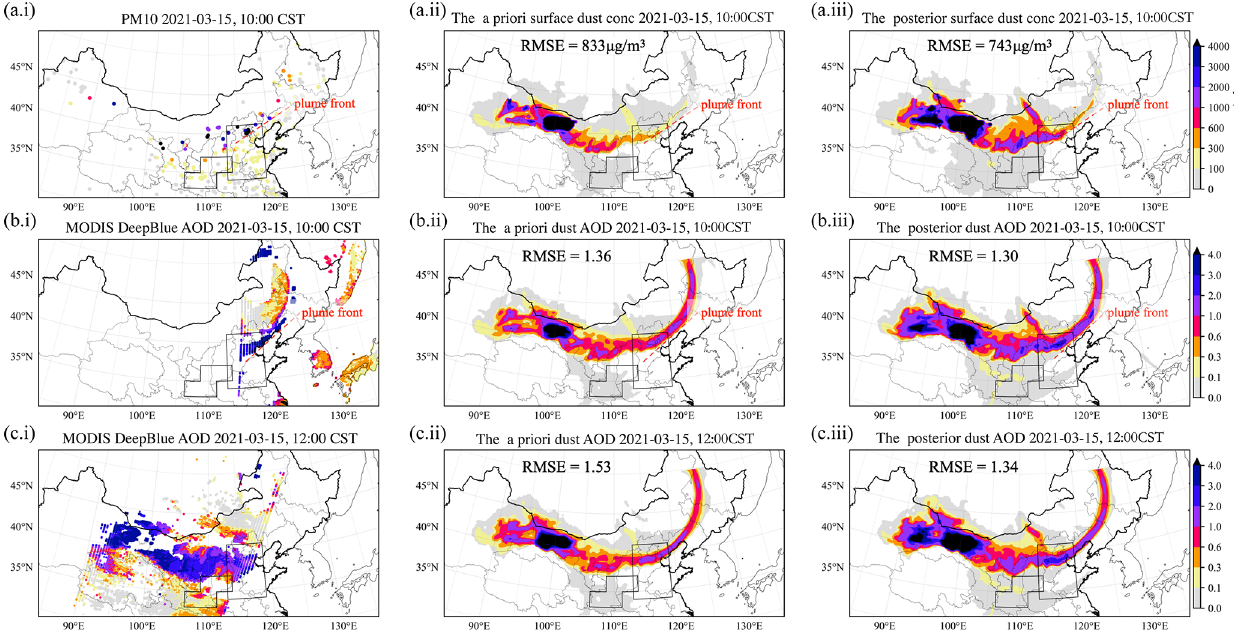
Figure 2. Snapshots of observations and simulations during severe dust event 1 (SD1) at 15 March 2021. Row (a) shows PM 10 concentrations observed by ground network at 10:00CST (i) , and a priori (ii) and posterior (iii) simulations by the LOTOS-EUROS/dust model. Similarly, row (b) shows for the same hour AOD at 550nm from MODIS Deep Blue observations (i) and simulations (ii–iii) at 10:00; row (c) shows the same for the MODIS overpass at 12:00.